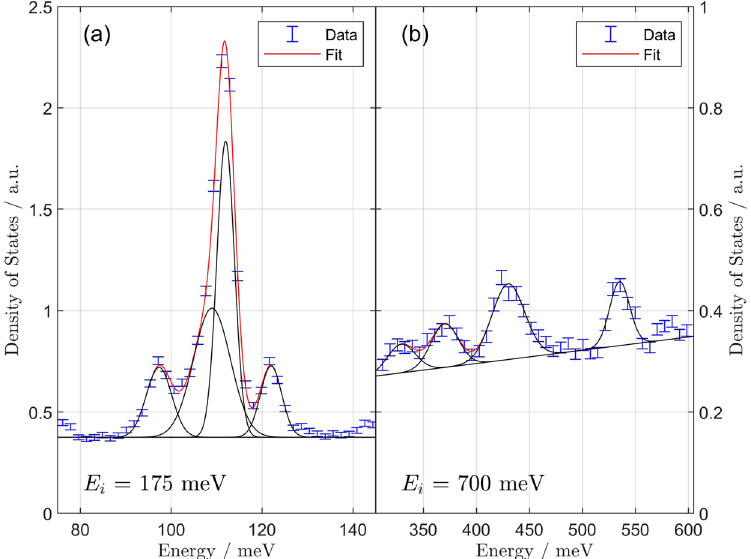
Figure 5. Detailed view of the neutron-weighted (“generalized”) phonon density of states as measured with ( a ) 175 and ( b ) 700 meV incident energy neutrons. The fits in panels (a, b) are a sum of four Gaussian components and a linear background. The fit parameters are provided in Table 1. In panel (a), the symmetric and asymmetric uranyl stretching bands are observed at 112 and 122 meV, respectively. The former also shows a redshift shoulder at 109 meV. The presence of water modes in panel (b) suggests interactions between water and the uranyl ion could be responsible for the redshift shoulder of the symmetric mode. The addition of a coupled water molecule adds 1 u to the effective mass of the O yl atom, such that the frequency will be